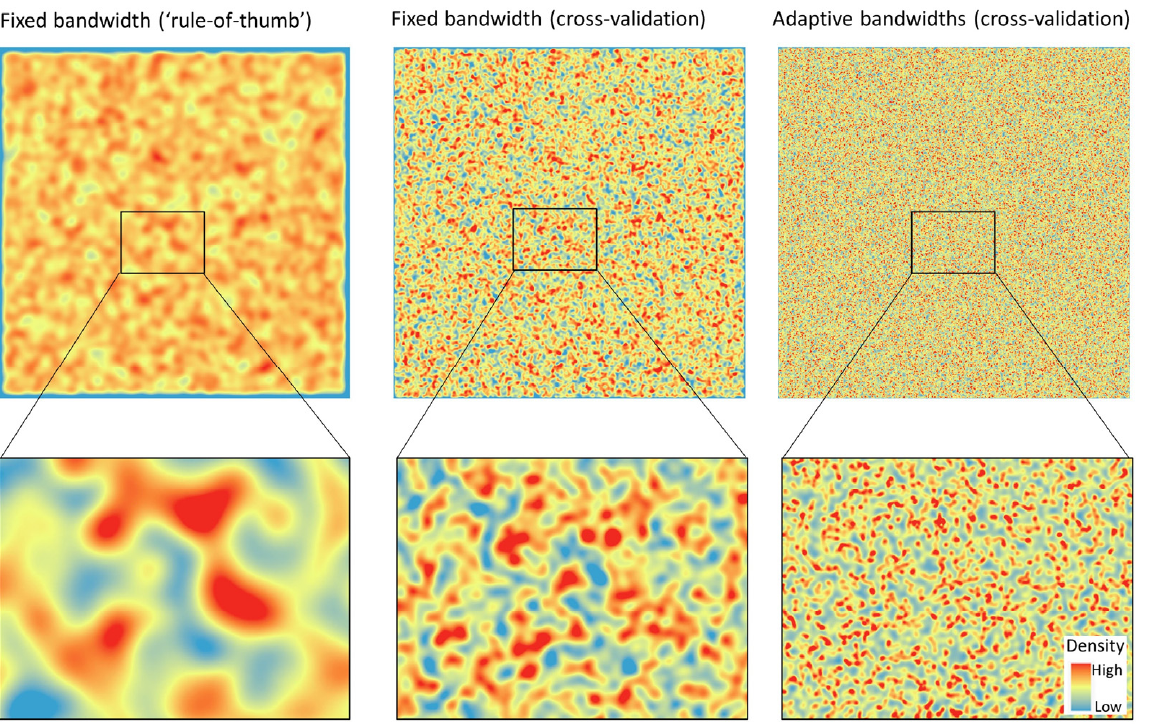
Figure 7. Density rasters estimated with different bandwidth options on a synthetic dataset ( n = 1,000,000 points; density raster cell size = 0.05).